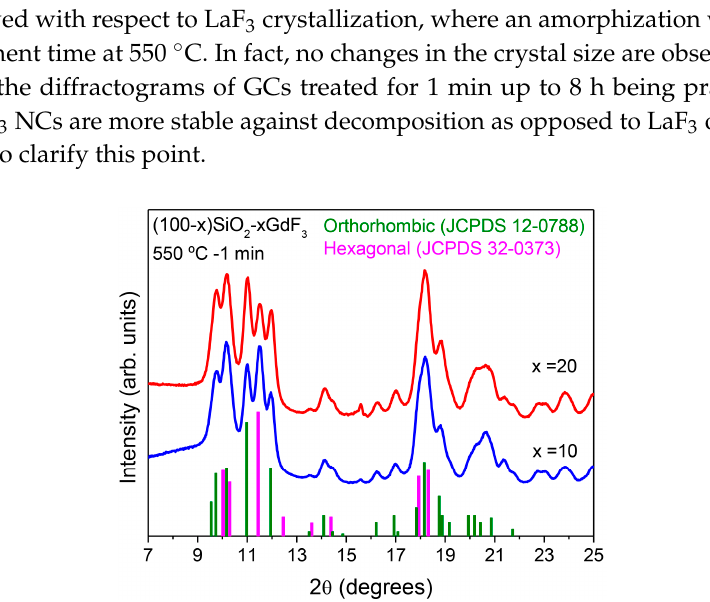
Figure 15. XRD of (100 − x)SiO 2 -xGdF 3 (x = 10 and 20 mol %) GC treated at 550 °C for 1 min performed at the synchrotron SpLine BM25 of the ESRF.